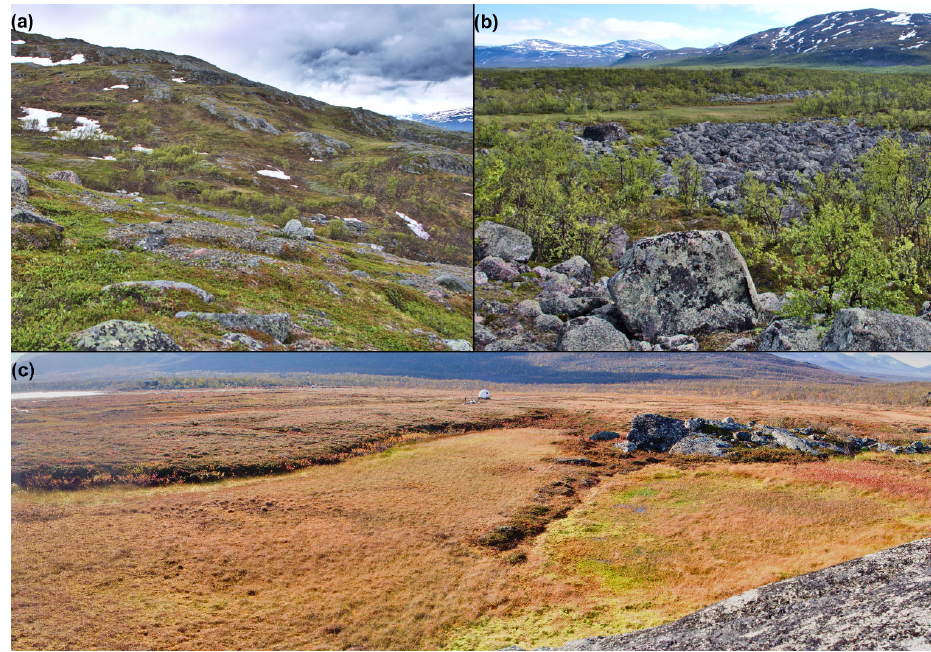
Figure 2. Photographs exemplifying the study area. (a) Alpine landscape mosaic showing several land cover classes including bare ground and alpine tundra heath transitioning into birch forest. (b) Lowland landscape mosaic showing sparse birch forest, blockfields and a small wetland in the direct neighborhood. (c) Raised permafrost peat plateau (left) with sharp transition to Sphagnum -dominated wetland areas and exposed bedrock areas